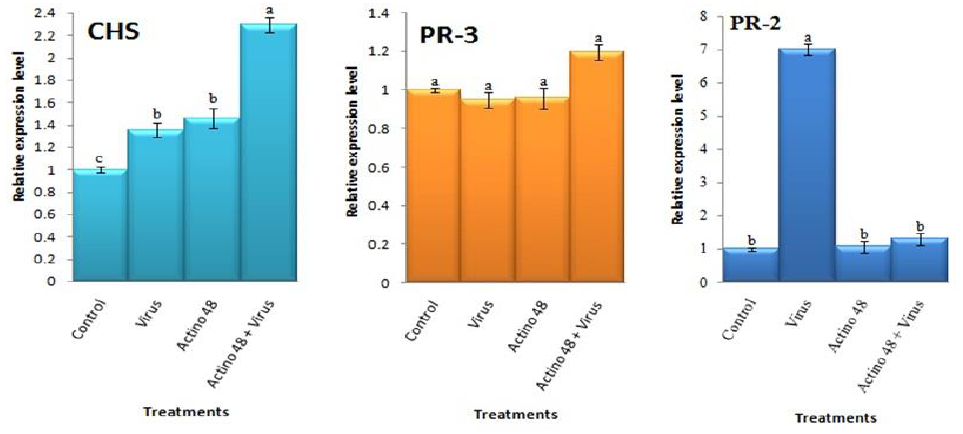
Figure 6. The relative expression levels of the chalcone synthase (CHS), protein 3 (PR-3), and pathogen-related protein 2 (PR-2) genes in TMV-infected tomato plants at 21 days post-inoculation. Columns with the same letter do not differ significantly.